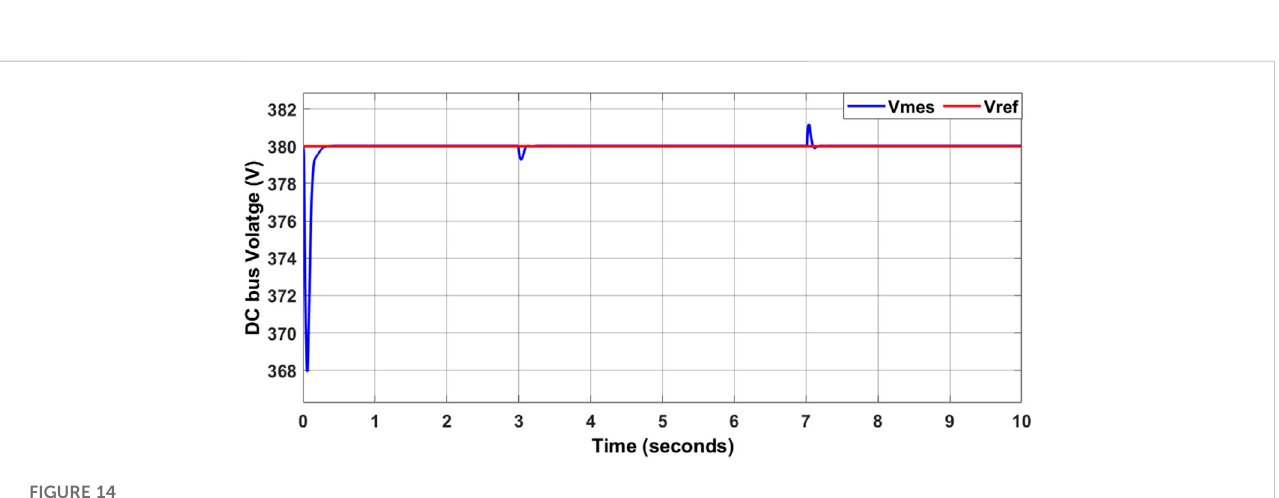
FIGURE 14 Simulation result of DC bus voltage.